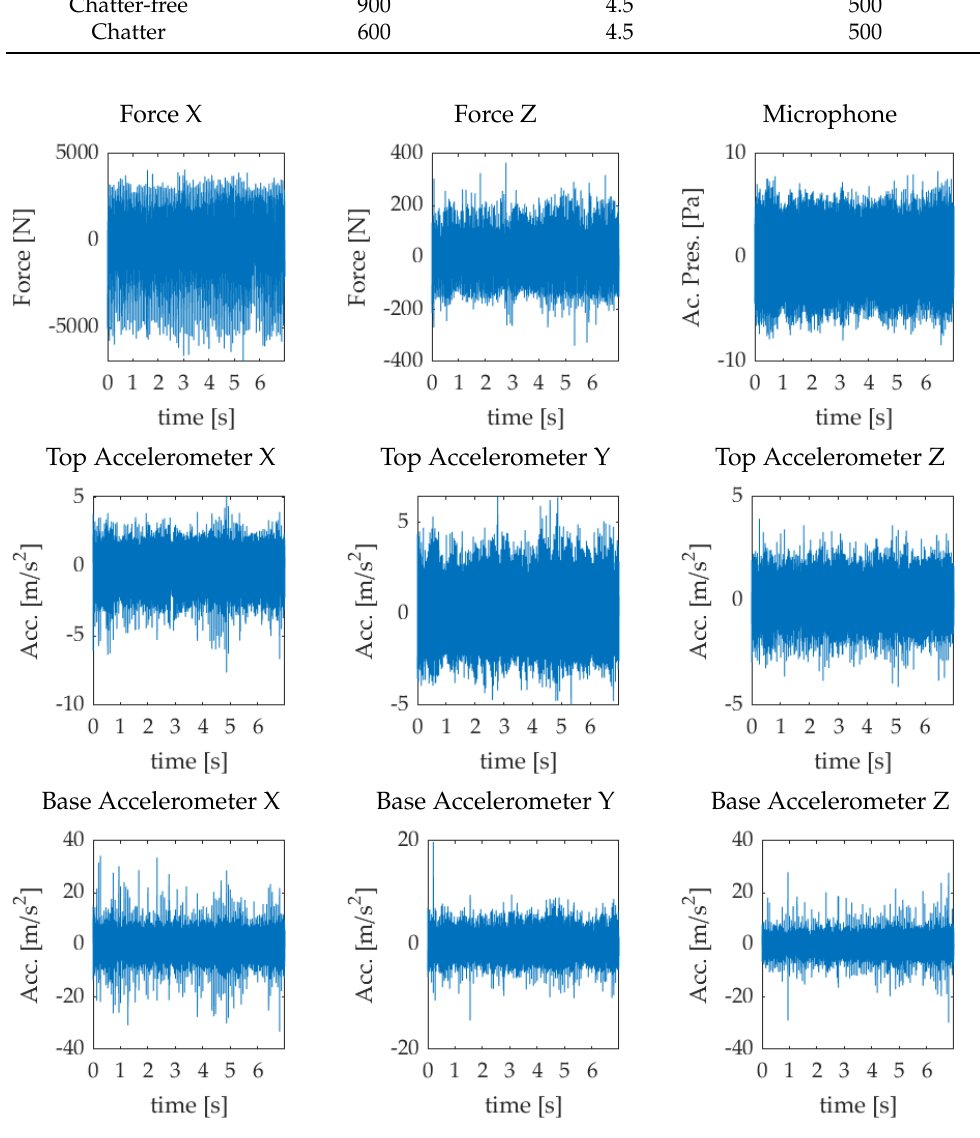
Figure 7. Signals acquired during chatter-free